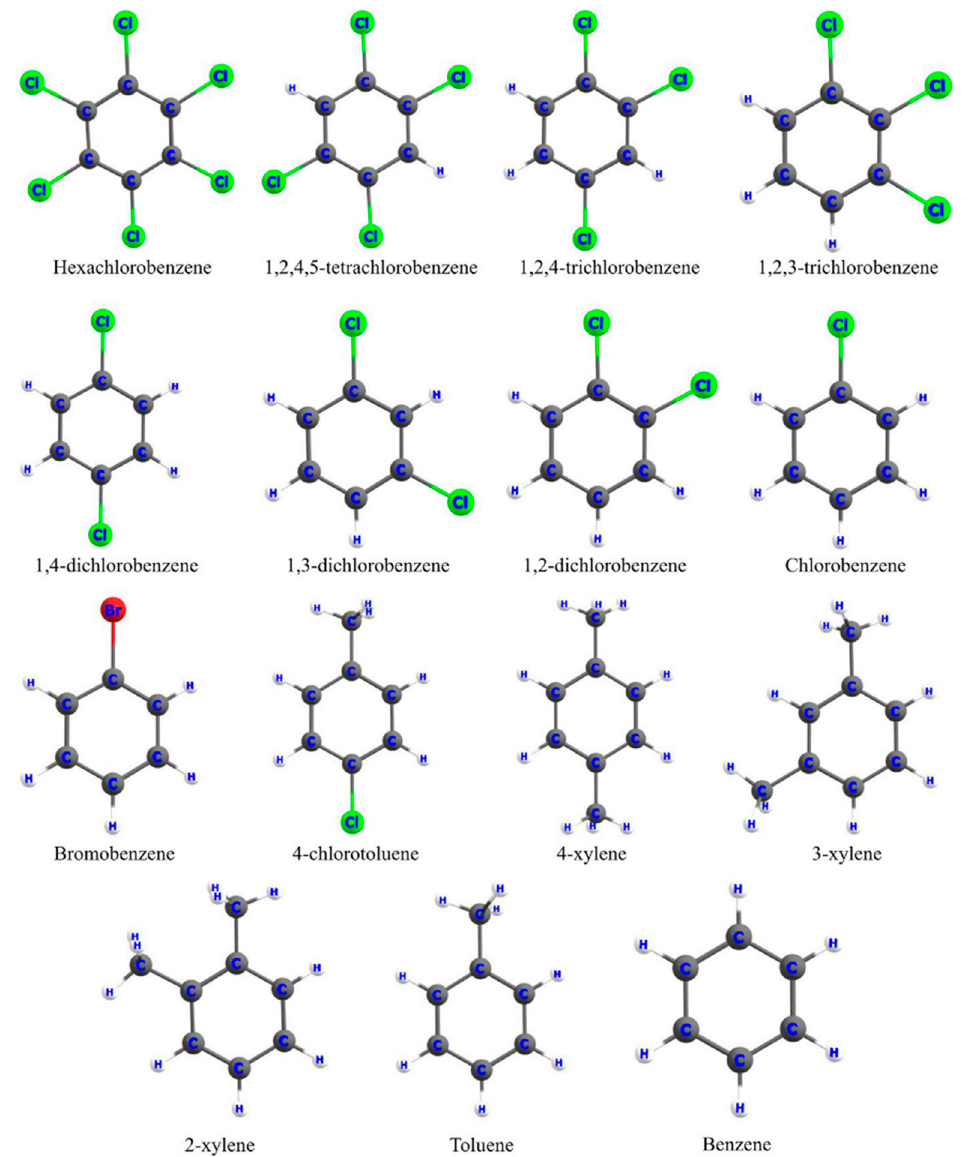
Figure 1. Geometries of the substituted benzene derivatives optimized at the B3LYP/6-31G(d) level of theory (reprinted from ref. [56] with permission from John Wiley & Sons. © 2018 John Wiley & Sons A/S).